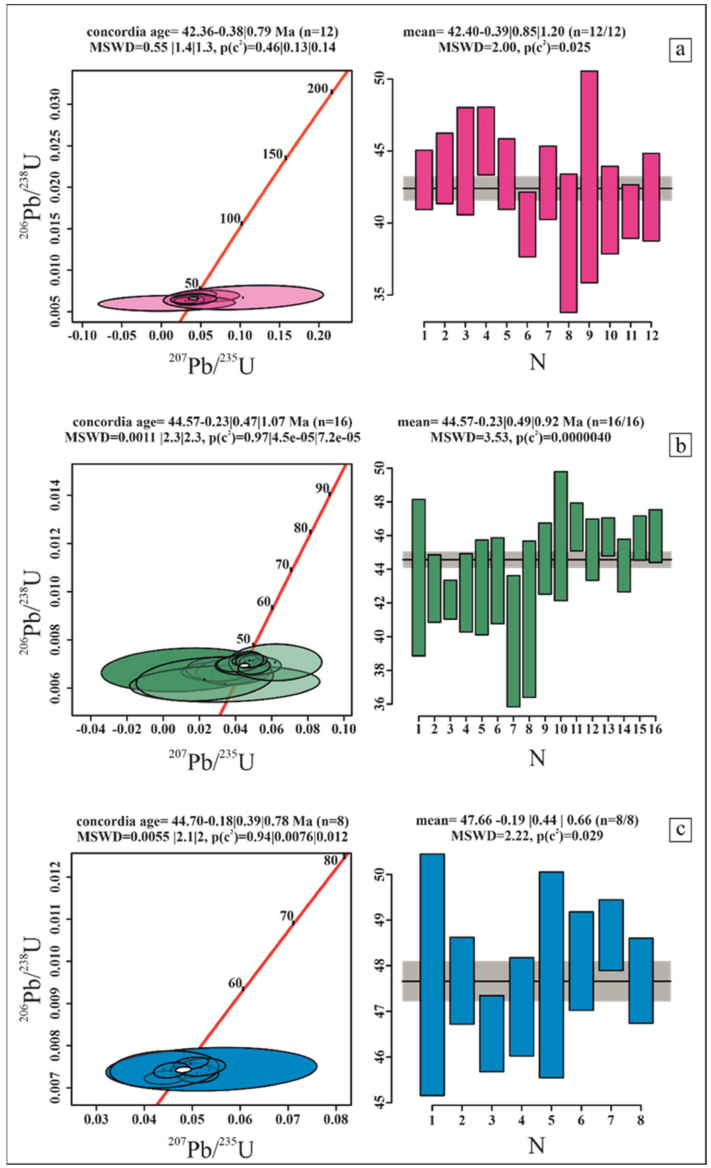
Figure 9. Concordia diagram and weighted mean 206 Pb/ 238 U age (Ma) for samples ( a ) Castelletto di Rotzo, ( b ) Lonedo, and ( c ) Le Fosse di Novale. The grey lines in the weighted mean plots show the calculated pooled ages for each